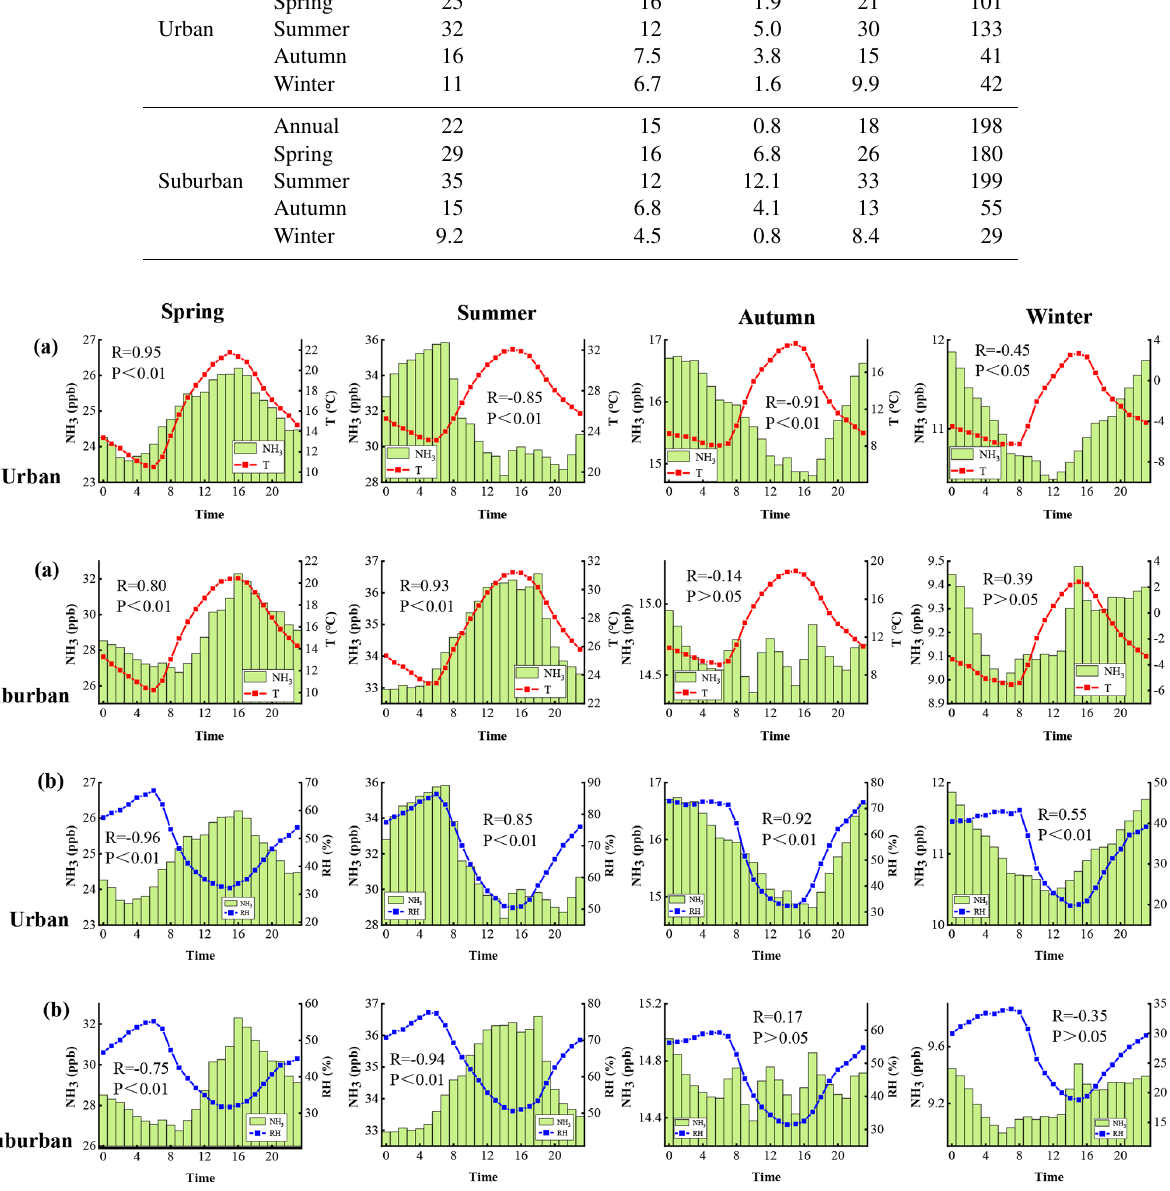
Figure 5. Diurnal variations in and correlation coefficients between the NH 3 mixing ratios and the respective temperature (a) and relative humidity (b) in different seasons at the urban and suburban sites in